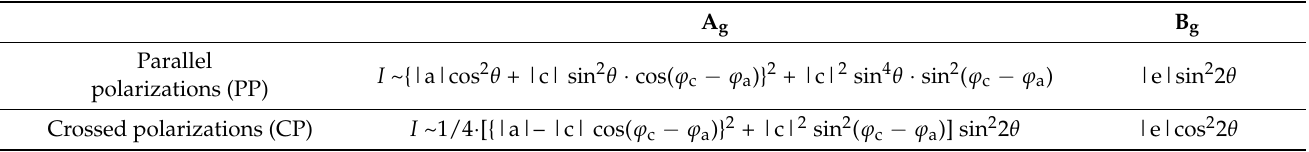
Table 5. Expressions for angle dependence of Raman lines of A g and B g symmetry for parallel and crossed